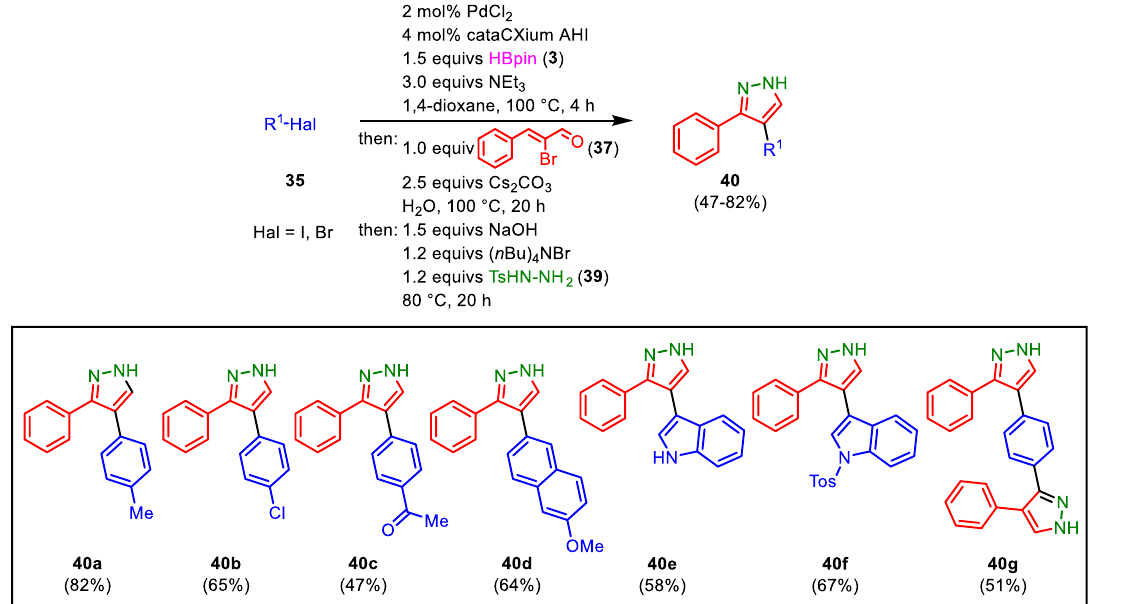
Figure 25. One-pot MBSC sequence as an entry to the consecutive three-component MBSC-cyclocondensation synthesis of 3,4-diaryl 1 H -pyrazoles 40 [54].